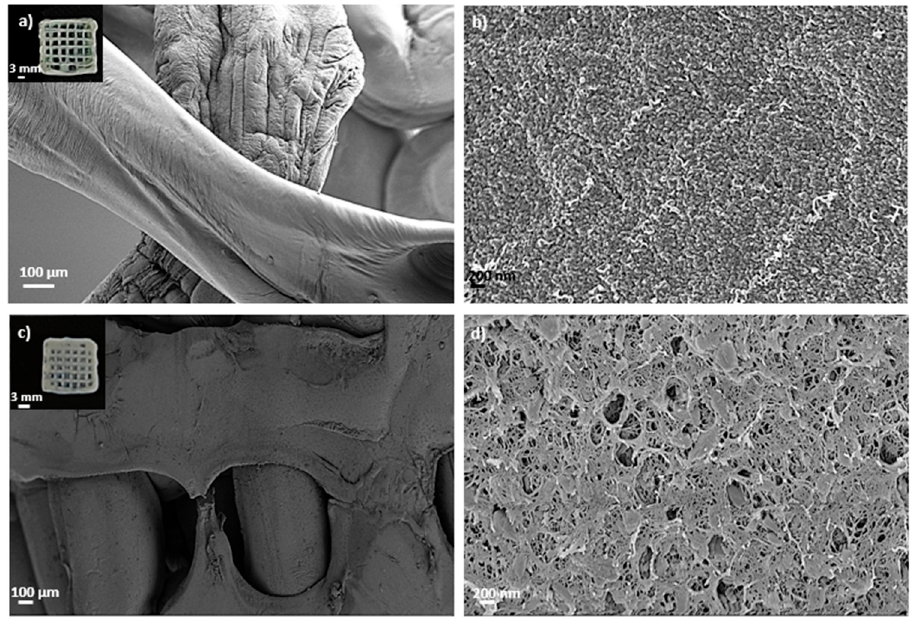
Figure 2. SEM images of 3D-printed aerogel scaffolds prepared from alginate 6 wt.% inks ( a , b ) with- out and ( c , d ) with a one-hour ageing step in 1 M CaCl 2 solution. Aerogels were observed at two different magnifications. Intake in ( a , c ): visual appearance of the aerogel scaffolds with a well-defined 3D-pattern.